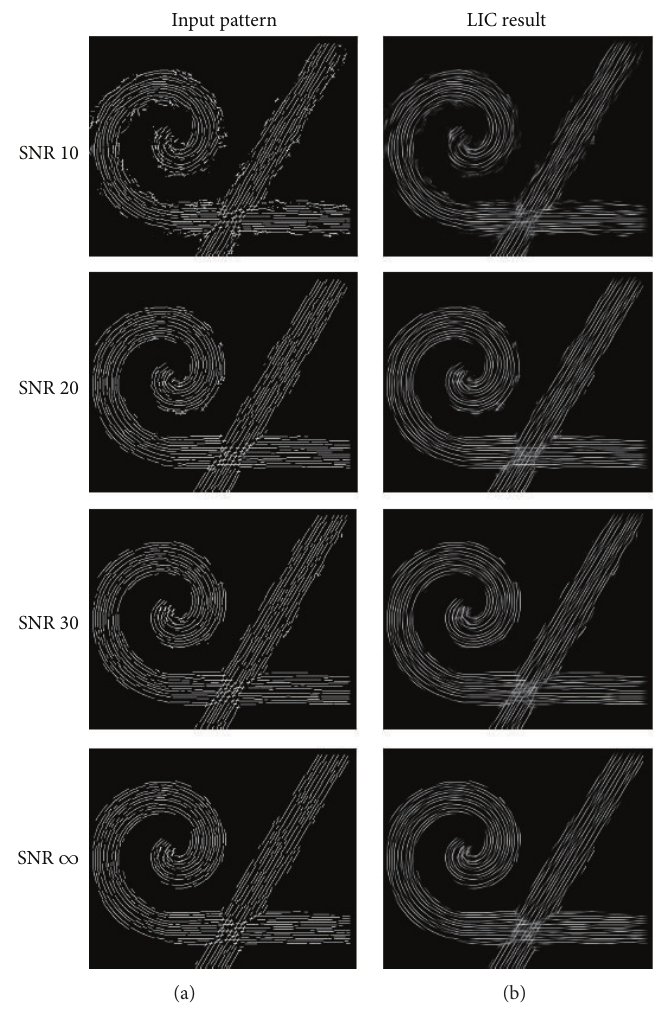
Figure 13: Results from the simulation study demonstrating the influence of SNR on multicylindrical glyph sample (a) and LIC result (b).